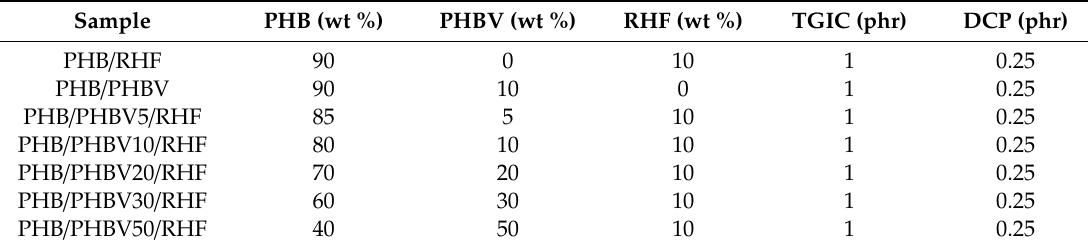
Table 1. Set of formulations prepared according to the weight content (wt %) of poly(3-hydroxybutyrate) (PHB), poly(3-hydroxybutyrate- co -3-hydroxyvalerate) (PHBV), and rice husk flour (RHF) in which triglycidyl isocyanurate (TGIC) and dicumyl peroxide (DCP) were added